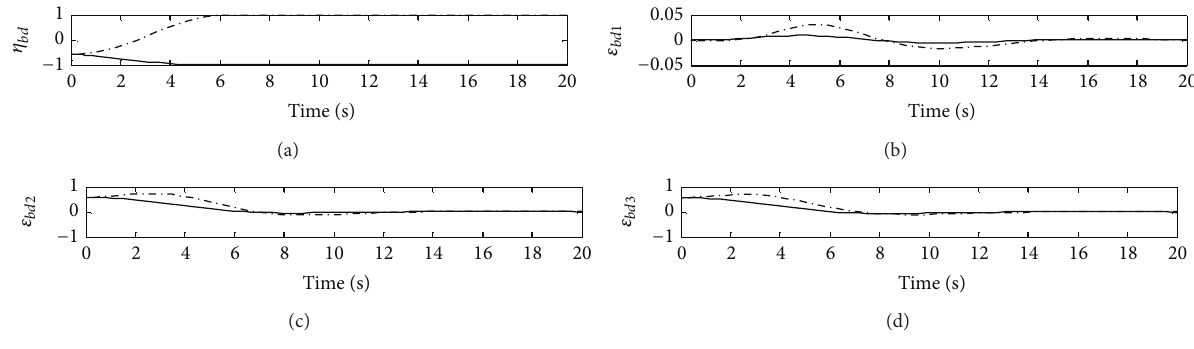
𝑇 =[𝜂 𝜀 𝜀 𝜀 ] 𝑇 ; Theorem 3 (solid line) and PD-like control law (dash-dot line). 𝑏𝑑 𝑏𝑑1 𝑏𝑑2 𝑏𝑑3